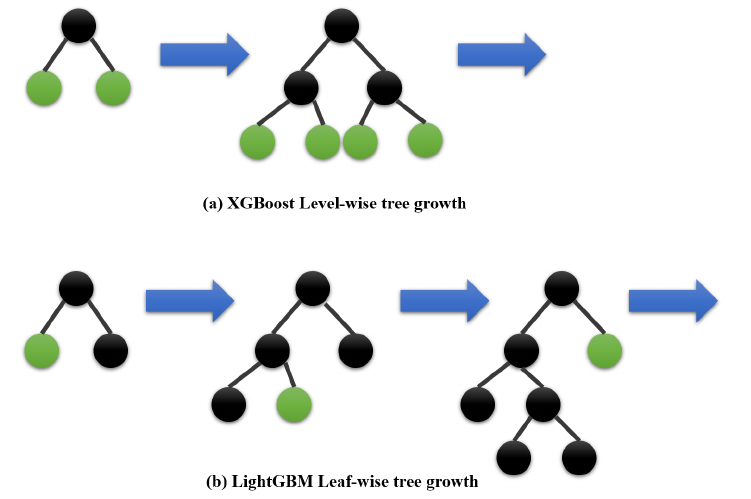
Figure 3. XGBoost vs. LightGBM tree